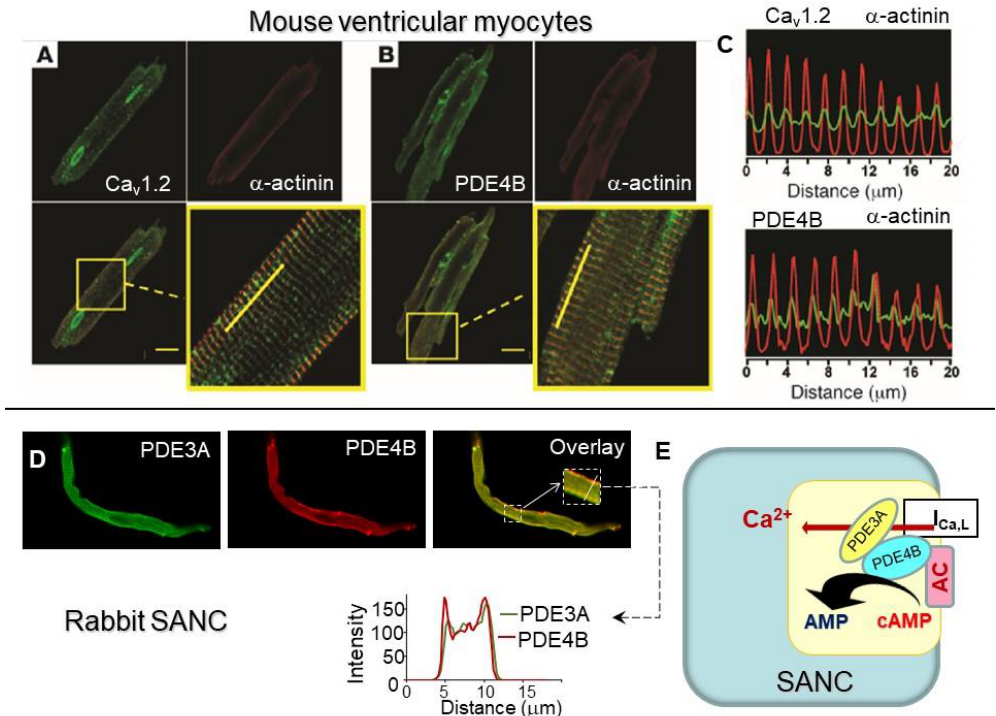
Figure 6. Co-localization of PDE4B with L-type Ca 2+ channels in ventricular myocytes and SANC. ( A – C ) (with permission from [85]): ( A ) Localization of PDE4B and L-type Ca 2+ channels at the transverse tubules (t-tubules) in mouse ventricular myocytes. Confocal images of WT mouse ventricular myocytes double labeled with anti-Ca V 1.2 antibody (green) and anti- α -actinin antibody (red). ( B ) Confocal images of a WT mouse ventricular myocytes double labeled with anti-PDE4B antibody (green) and anti- α -actinin antibody (red). Scale bar: 20 µ m. ( C ) Graphs indicate the relative fluorescence intensities in the green and red channels measured along a 20- µ m distance, as indicated by the yellow line on the enlarged boxed area from the merged images. ( D ) Distribution of PDE3A and PDE4B in single rabbit SANC, which do not have t-tubules: green fluorescence staining for PDE3A and red fluorescence staining for PDE4B (negative control had negligible fluorescence). Superimposed images (Overlay) and intensity plot (below) show overlapping distribution of PDE3A with PDE4B beneath sarcolemma (from [11]). ( E ) Cartoon shows plausible PDE3/4-dependent regulation of AC-cAMP signaling in the vicinity of L-type Ca 2+ channels in